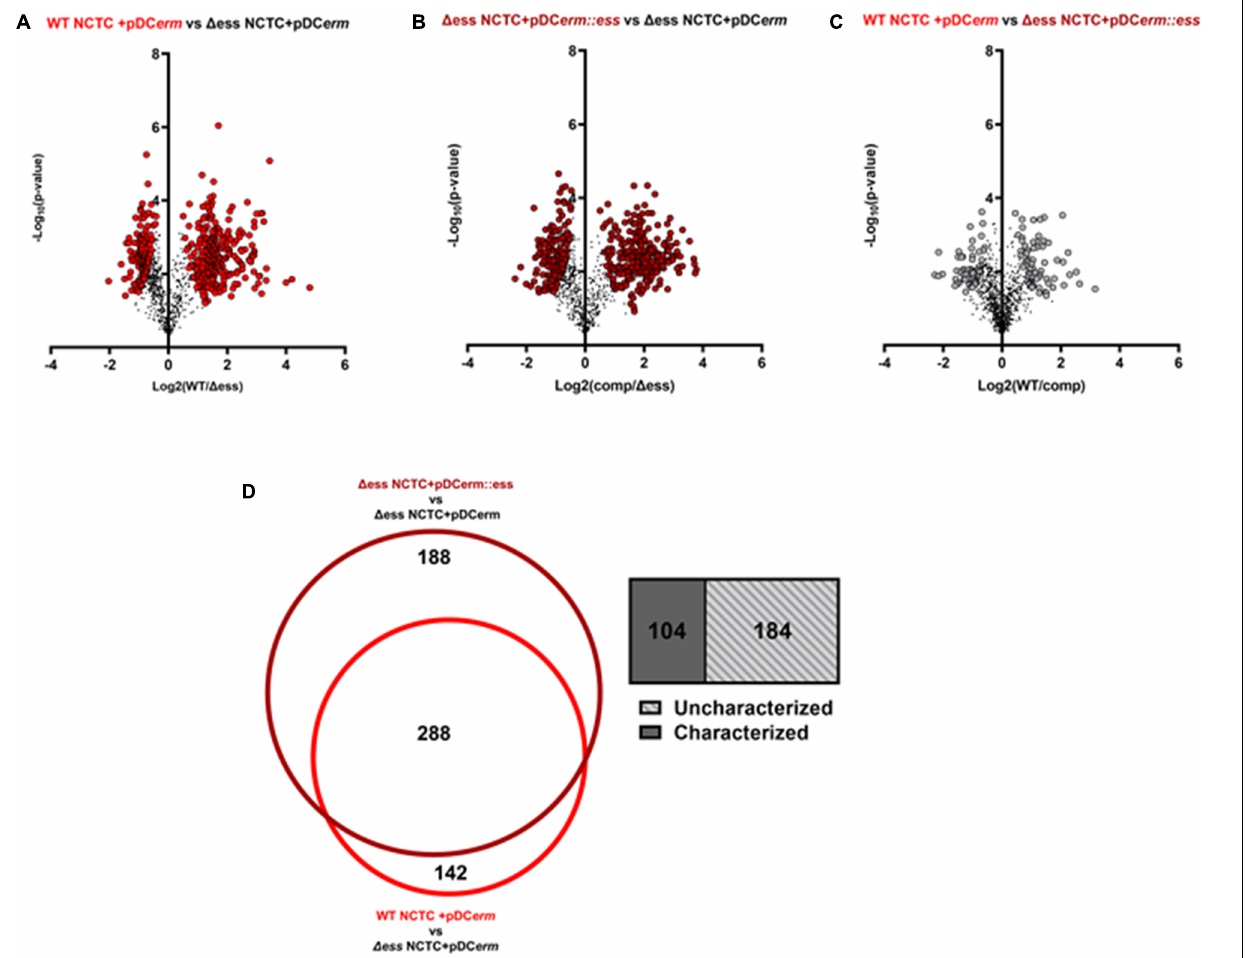
FIGURE 4 | (A) Volcano plots demonstrating a binary comparison of differentially abundant proteins in GBS culture supernatant of WT and S protein deletion strains. Proteins with pi-score > 1.5 are shown in bright red. (B) Volcano plots demonstrating a binary comparison of differentially abundant proteins in GBS culture supernatant of complemented and S protein deletion strains. Proteins with pi-score > 1.5 are shown in dark red. (C) Volcano plots demonstrating a binary comparison of differentially abundant proteins in GBS culture supernatant of complemented and S protein deletion strains. Proteins with pi-score > 1.5 are shown in gray. (D) Venn diagram showing overlap of differentially abundant proteins when making binary comparison of WT and complemented strains with S protein deletion strain. Box-plot demonstrating proportion of overlapping proteins determined to be uncharacterized on